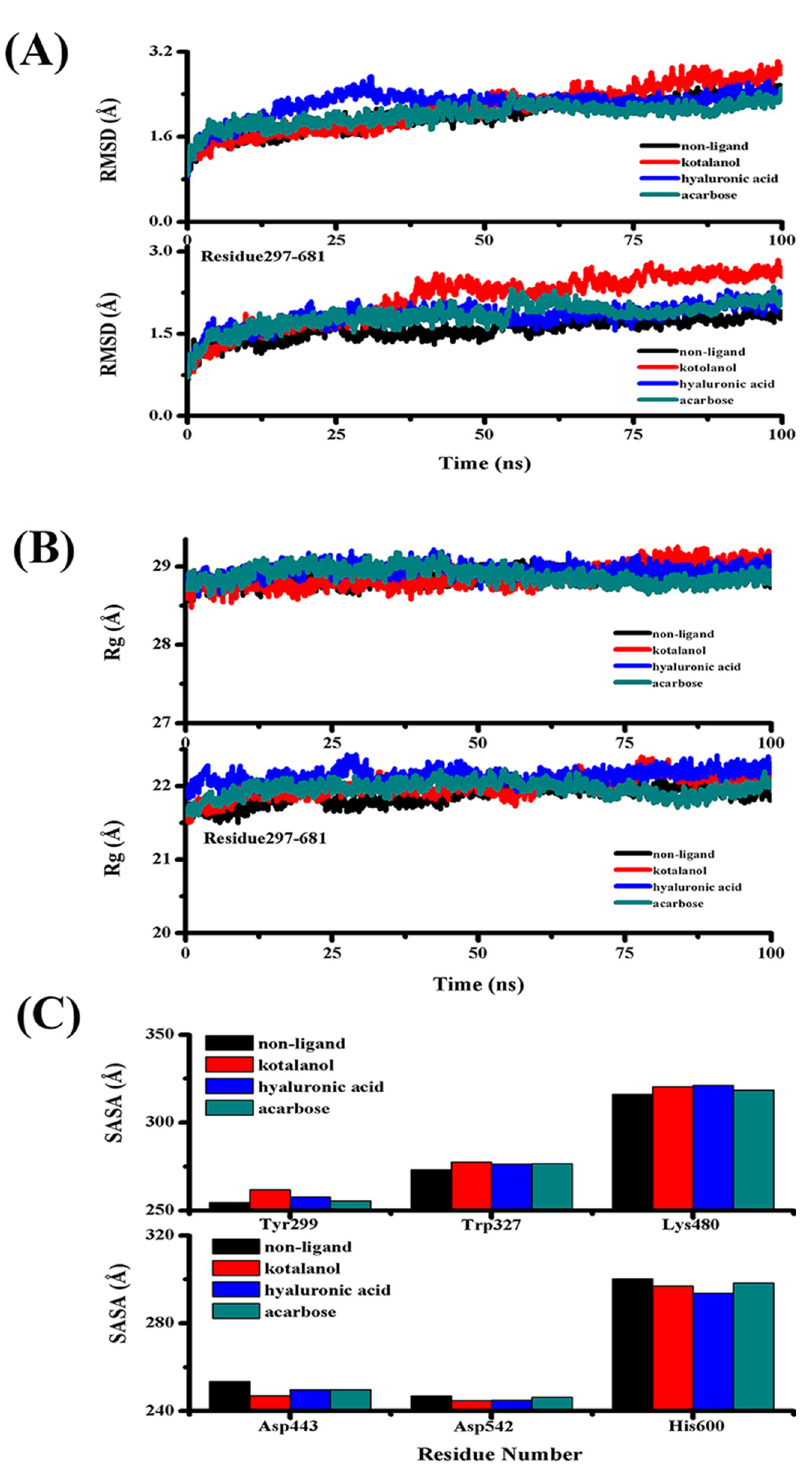
Fig 3. (A) The RMSD plot during MD simulations. (B) The Rg plot during MD simulations. (C) The SASA score.